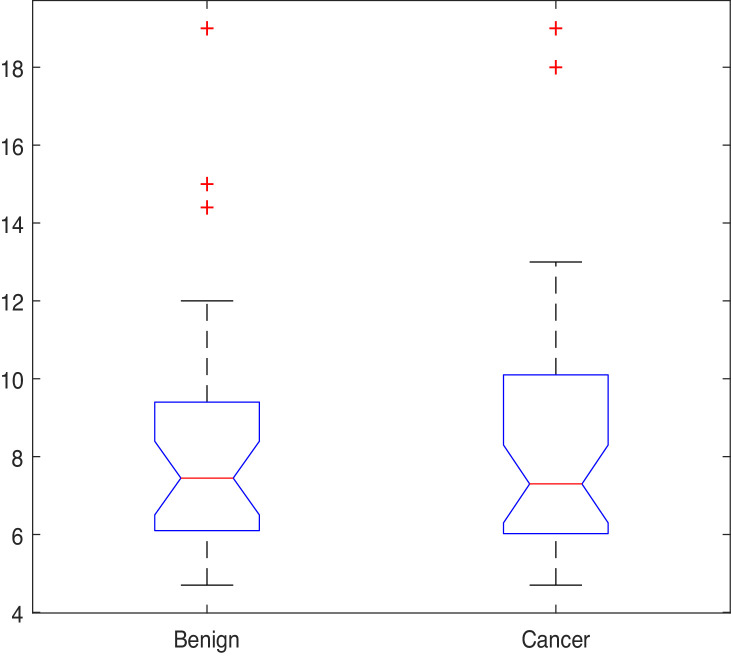
PSA values by group.